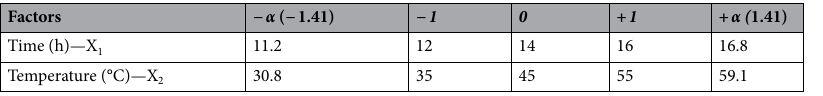
Table 1. Definition of the levels of the two variables studied in hot air convective drying of